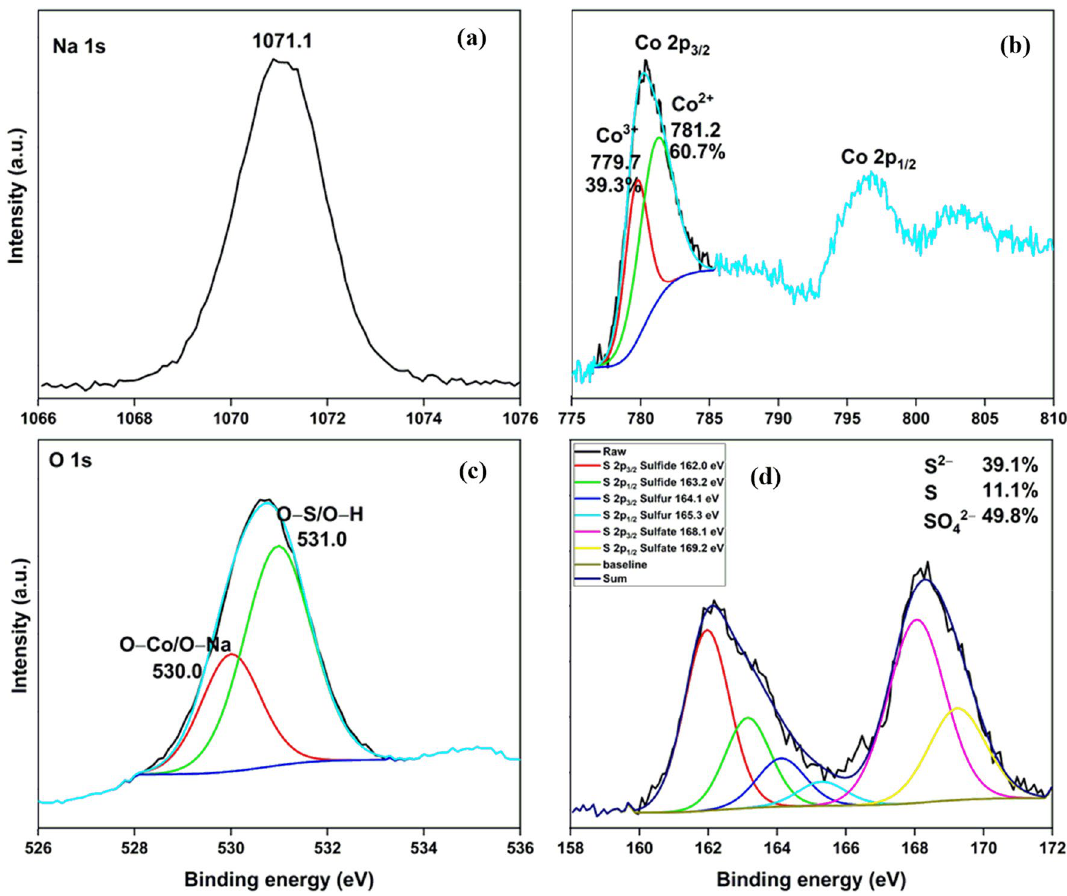
Figure 7. HRXPS ( a ) Na 1s; ( b ) Co 2p; ( c ) O 1s; ( d ) S 2p spectra of spent NCO-D in dry